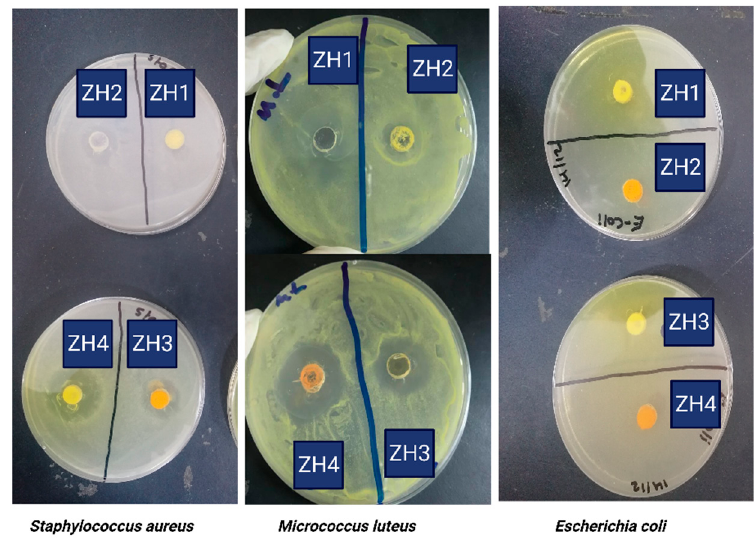
Figure 6. A representative bacterial culture showing the inhibition zone in Gram-positive ( Staphylococcus aureus and Micrococcus luteus ) bacteria by compounds ZH1 , ZH2 , ZH3 and ZH4 (( left ) and ( middle )) compared to lack of antimicrobial activity against Gram-negative bacteria ( Escherichia coli ) ( right ).